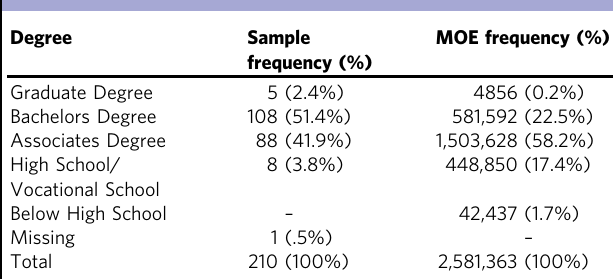
Table 2 Education level of study participants and in China generally (MOE,